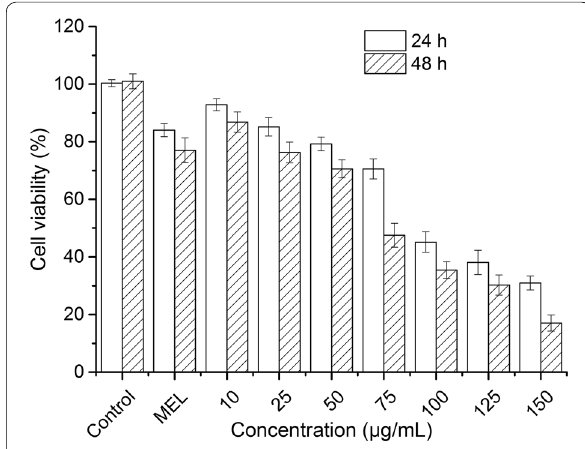
Different superscript letters in each row indicate significant differences